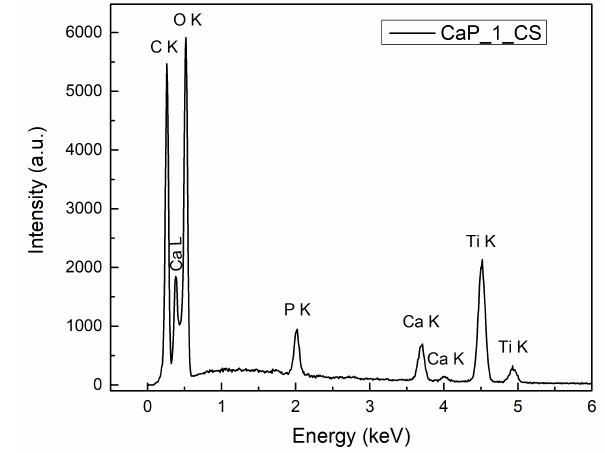
Figure 17. EDX spectrum of CaP_1_CS.